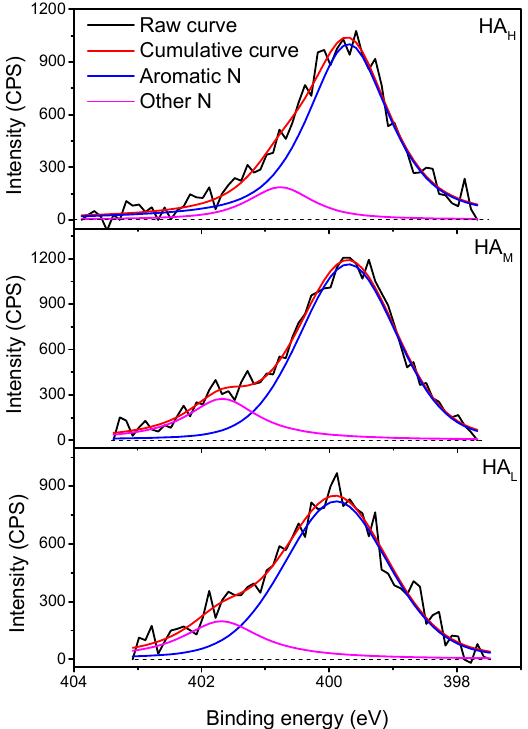
Figure 4. High-resolution N 1 s X-ray photoelectron spectra of HA fractions. The black dash line means the baseline of each sample. Other N indicates the peptide bond N or primary amine N.